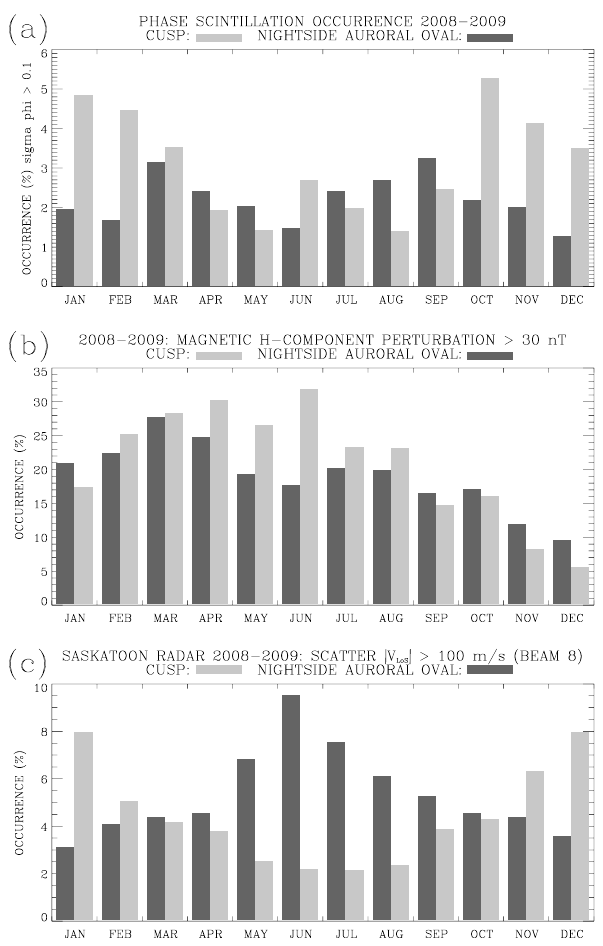
Fig. 7. Seasonal variation in the cusp and nightside auroral oval of the occurrence of (a) phase scintillation σ φ > 0 . 1 radians, (b) ground magnetic perturbation > 30nT, and (c) the F-region iono- spheric radar backscatter with LoS velocity exceeding 100ms − 1 .